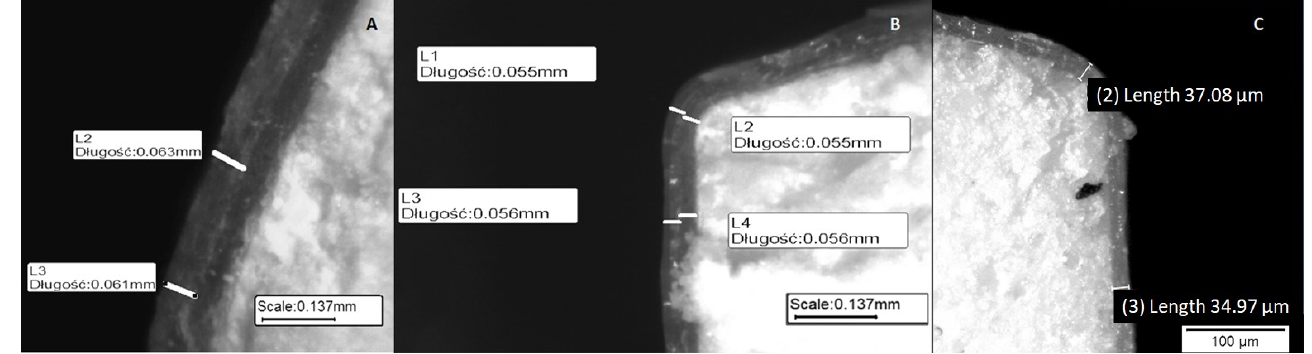
Figure 1. Example images of minitablet (MT) cross-sections obtained using a stereoscopic microscope: ( A ) MT-PE, ( B ) MT-PA, ( C ) MT-DE. Table 2. Characteristics of the fluid bed coating process: sub-coating and enteric coating (tested on two levels).